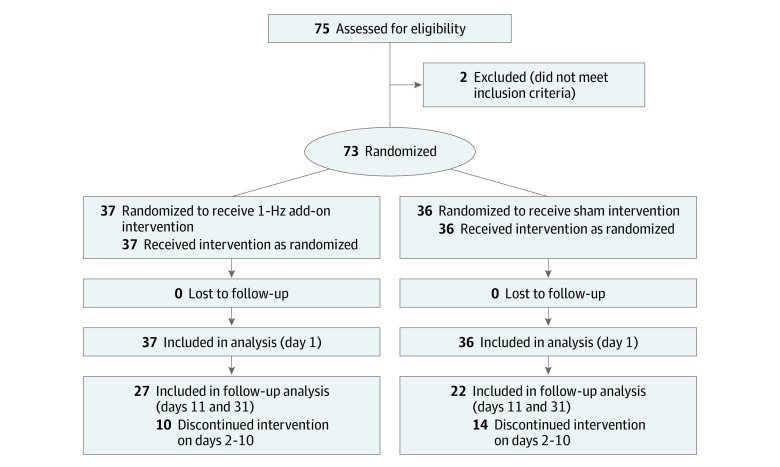
Study Flowchart